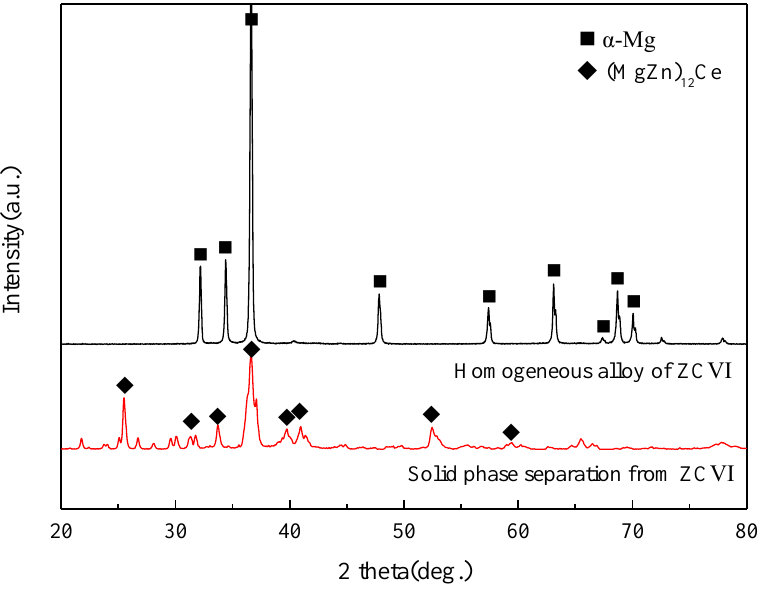
Figure 6. SEM microstructure images of the as-homogenized alloys. ( a ) ZCI, ( b ) ZCII, ( c ) ZCIII, ( d ) ZCIV, ( e ) ZCV, ( f ) ZCVI, ( g ) The morphology of ZCVI compound, ( h ) Separated solid phases sample of ZCVI. Figure 7 is the XRD spectrum of a typical homogeneous alloy and separated solid phase. Only the (Mg, Zn) 12 Ce phase exists in the calibration results of the homogeneous alloy, which indicates that the (Mg, Zn) 12 Ce phase can exist stably at this homogenization temperature. As a result, the Mg – Zn phase was not calibrated, indicating that the non- equilibrium phase such as Mg – Zn was fully decomposed in the homogenization process. As only the (Mg, Zn) 12 Ce phase in the homogeneous alloy compound contains the Ce ele- ment, the mass fraction of the (Mg, Zn) 12 Ce phase in the alloy can be calculated according to the Ce content in the compound (the difference between the Ce addition amount and the solid solution amount), and the results are shown in Table 4.